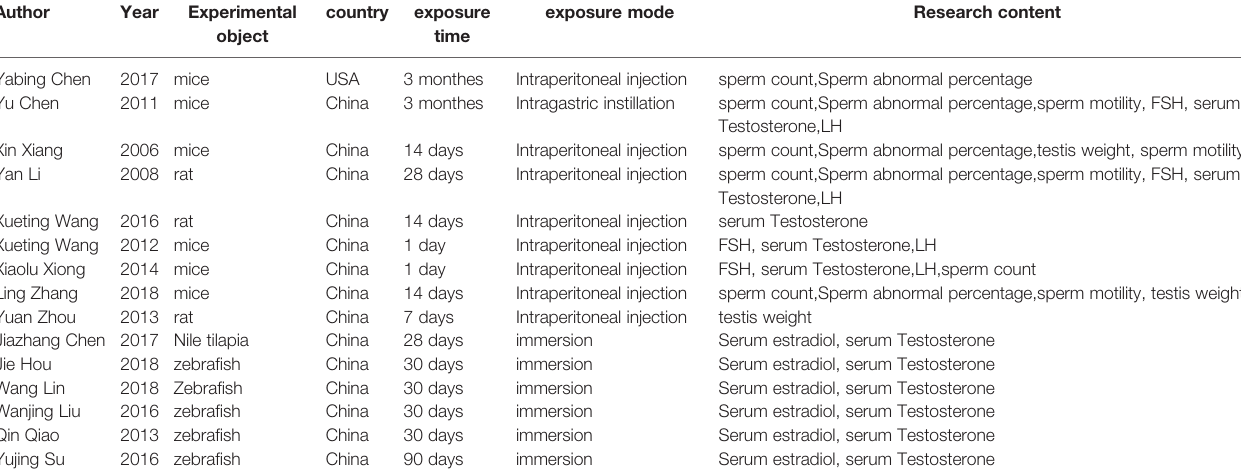
TABLE 1 | The characteristics of the included studies by year of publication and fi rst author, including the results of